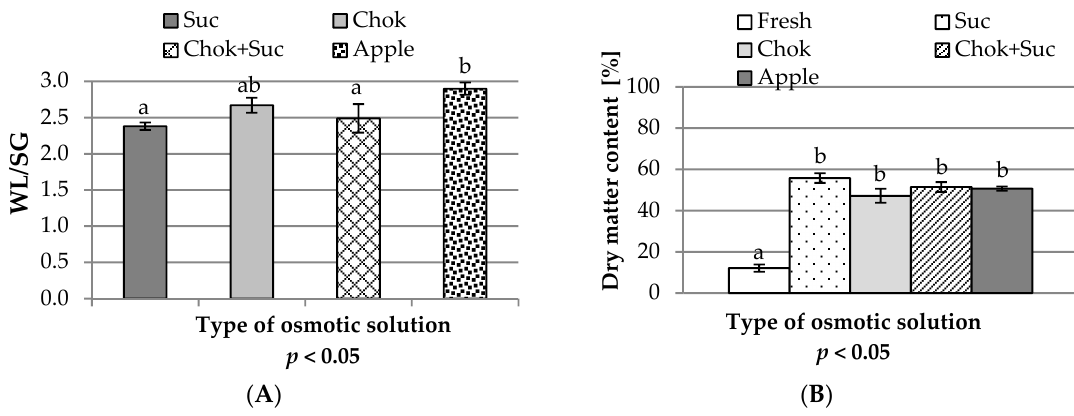
Figure 1. Influence of the type of osmotic solution on: ( A ) dehydration e ffi ciency factor (water loss to solid gain (WL / SG) ratio) and ( B ) dry matter content of osmo-dehydrated (at 50 ◦ C for 24 h) quince slices. Designations: a, b—homogeneous groups; sucrose solution (Suc), chokeberry juice (Chok), Chok + Suc, apple—coding the type of osmotic solution, as given in the experimental procedures.